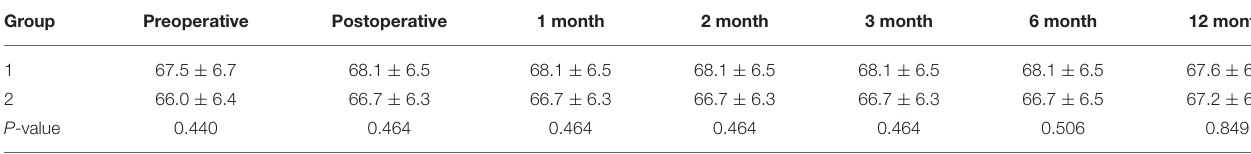
TABLE 5 | Central vertebral body height of the two groups (mm). Group